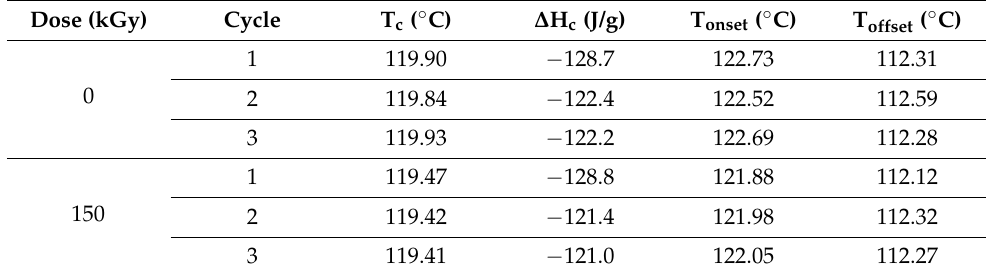
Table 9. Kinetic parameters of the crystallization curve of (CB + Gr)/HD.